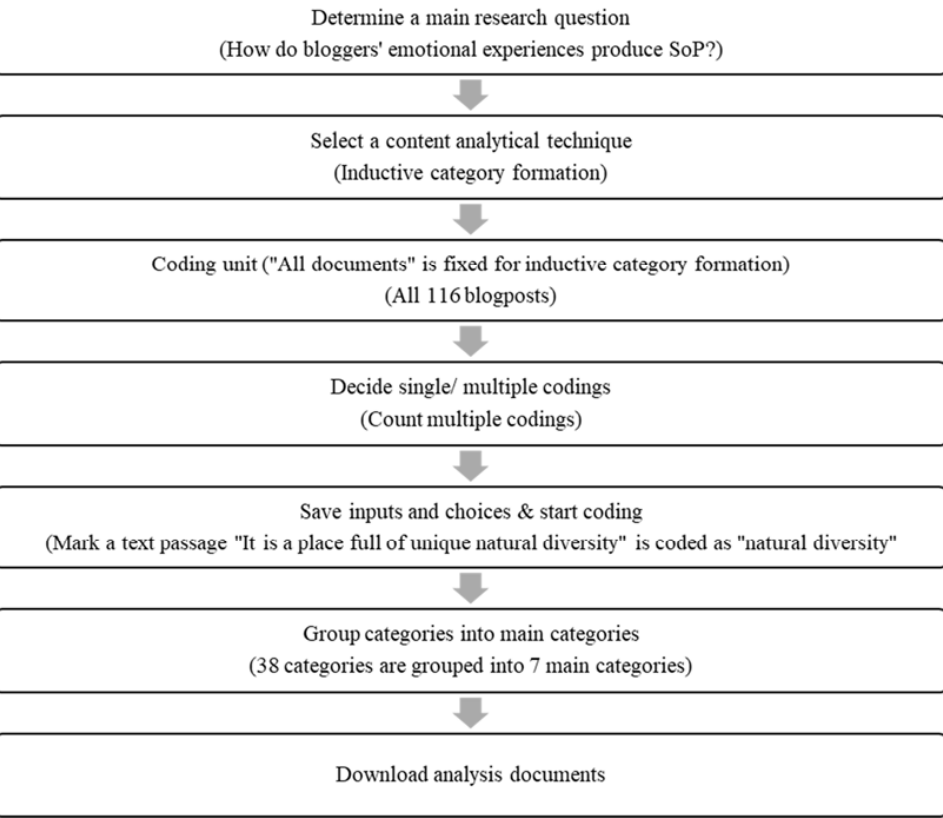
Figure 3. Steps of